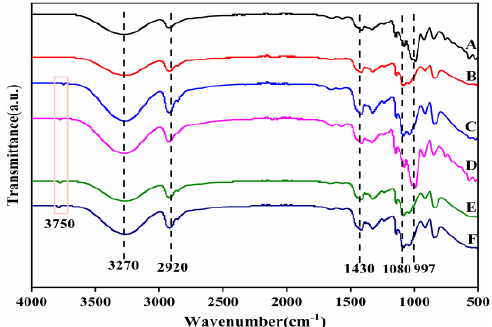
Figure 5. The FTIR spectra of composite membrane samples (A) starch − PVA; (B) HNTs/starch − PVA; (C) CNF/starch − PVA; (D)HNTs − CNF/starch − PVA; (E) HNTs − KH560 − CNF starch − PVA; (F) HNTs − KH570 − CNF starch − PVA.